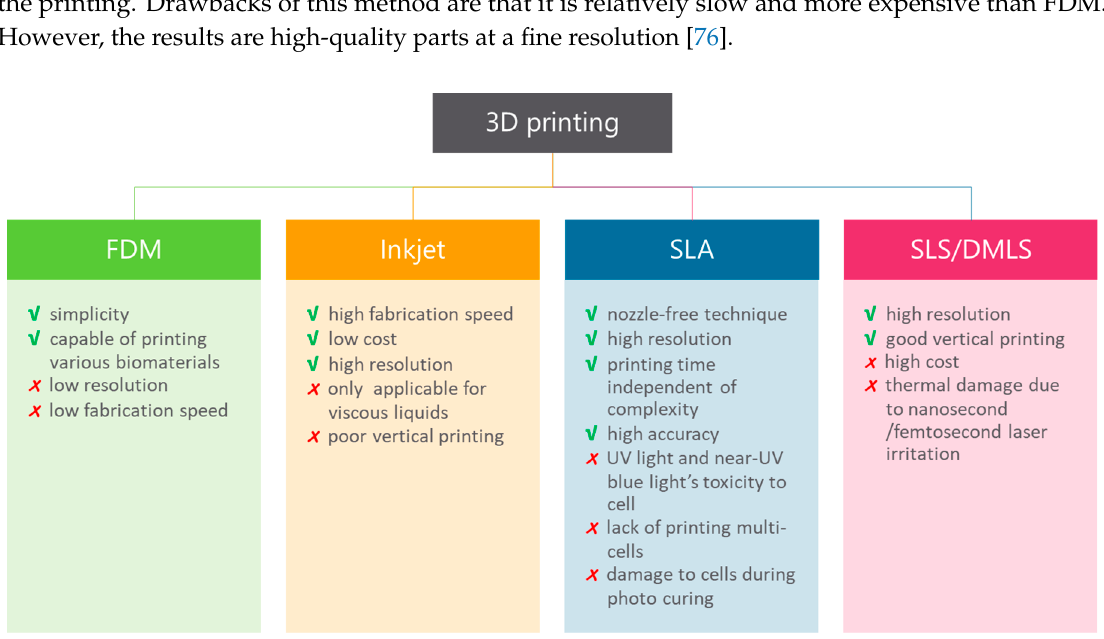
Figure 4. Advantages and limitations of 3D printing techniques. These techniques fabricate an object one layer at a time and include fused deposition modeling (FDM), inkjet bioprinting, stereolithography (SLA), laser sintering (SLS) and direct metal laser sintering (DMLS)